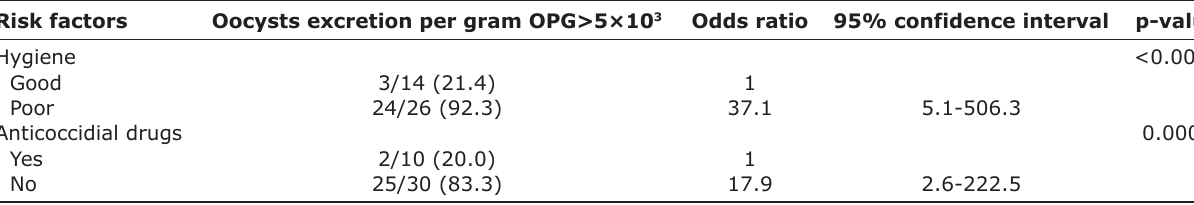
Table-4: Risk of intensity of coccidian infection in Algerian rabbit